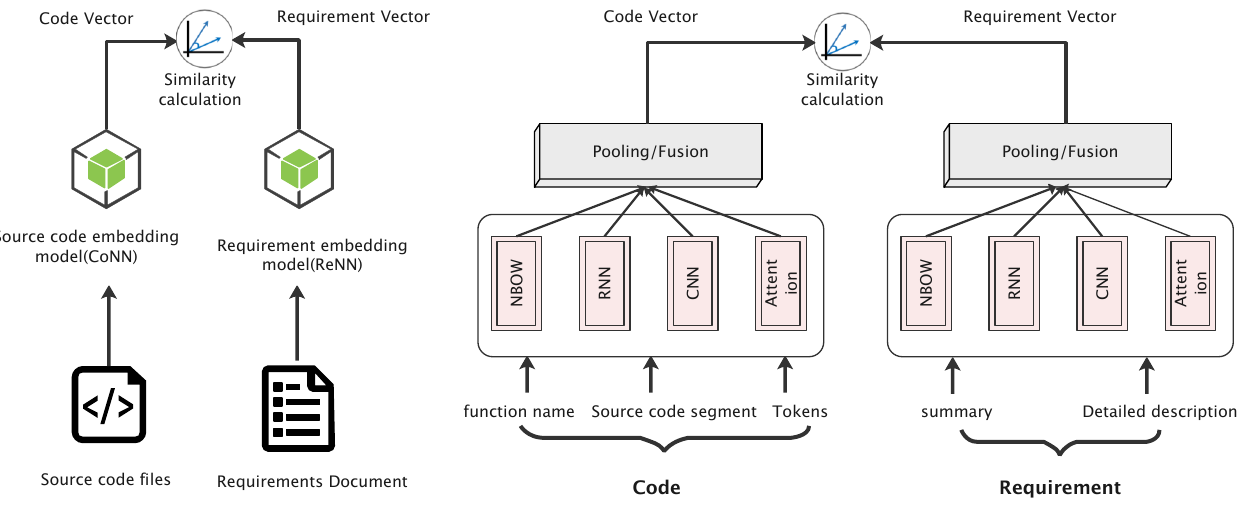
Figure 1. Tracing model between software requirement and source code based on neural